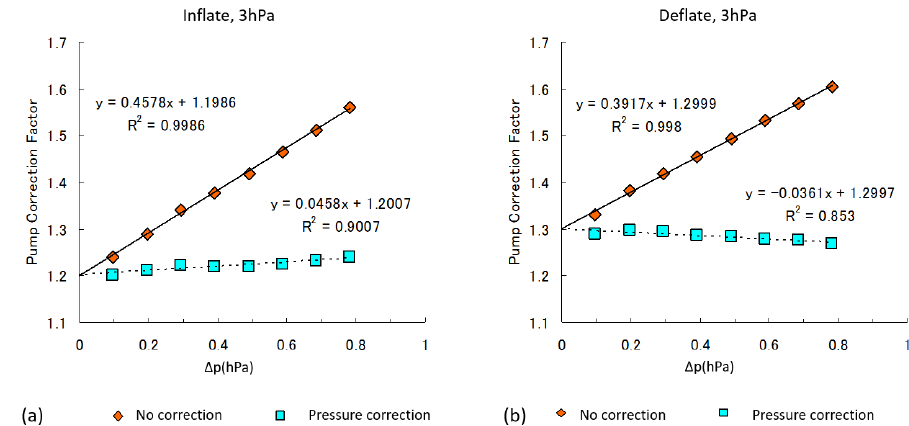
Figure 10. Pump correction factors calculated for various differential pressure thresholds. Values (representing the inverse of pump effi- ciency) are plotted with and without correction pressure correction. The values in panels (a) and (b) are based on the measurement times during expansion and contraction, respectively, at 3hPa ambient air pressure, as determined with the pump’s inlet and exhaust ports directly connected to a